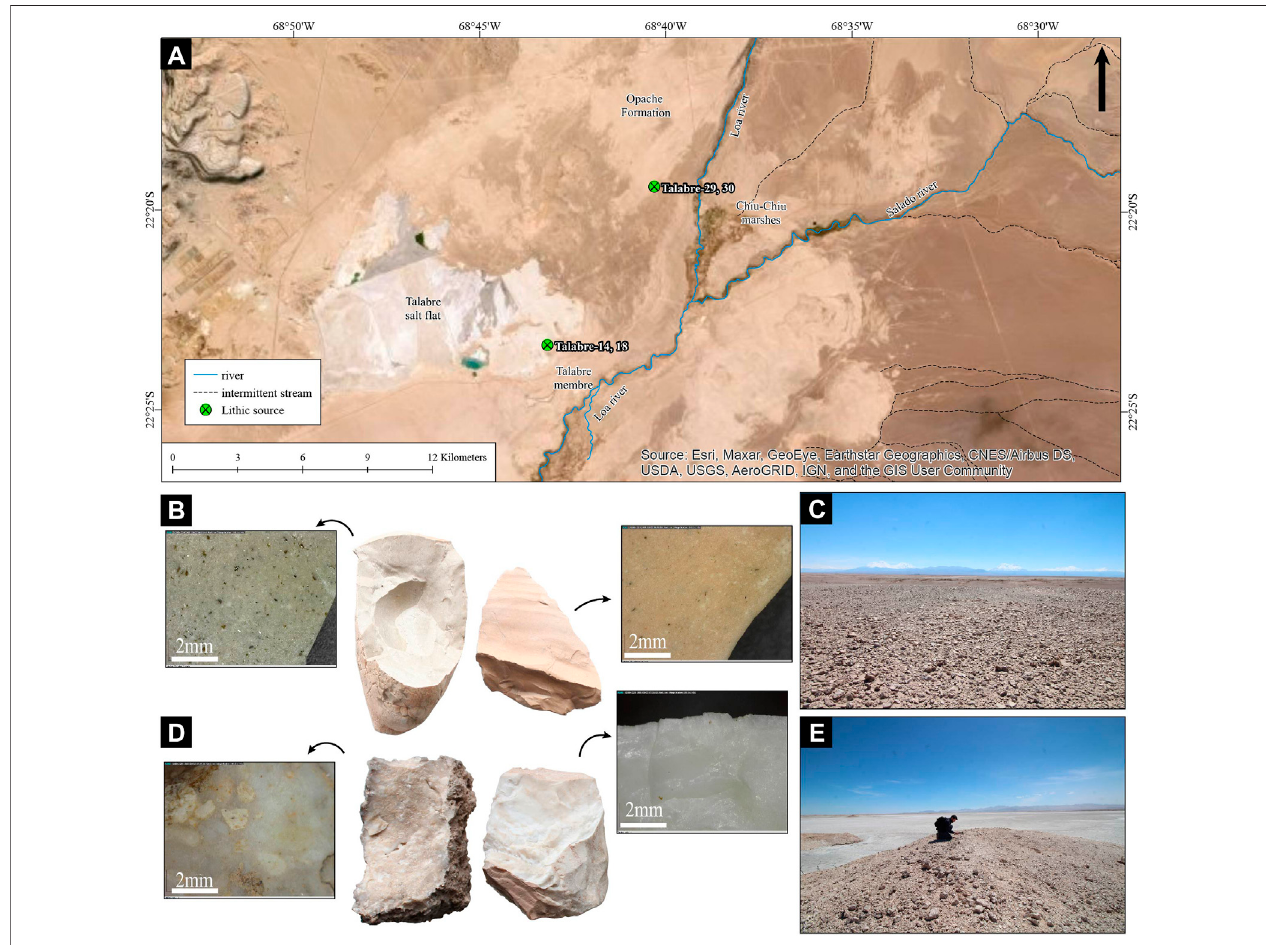
FIGURE 10 | Salar de Talabre source complex: (A) geological context; (B) raw material samples from Talabre-29 (left) and Talabre-30 (right) sites; (C) Talabre-30 quarry-workshop site; (D) raw material samples from Talabre-14 (right) and Talabre-18 (left) sources; (E) quarry-workshop site of Talabre-14.